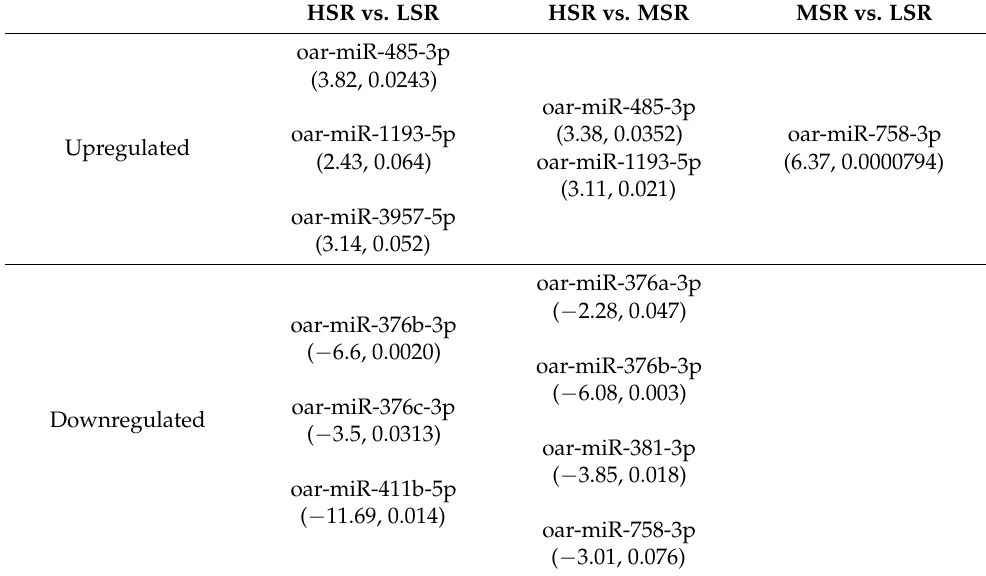
Table 2. Differentially expressed ovine miRNAs within variable stress-responding groups. Values represent fold change (FC), followed by the corresponding p-value.